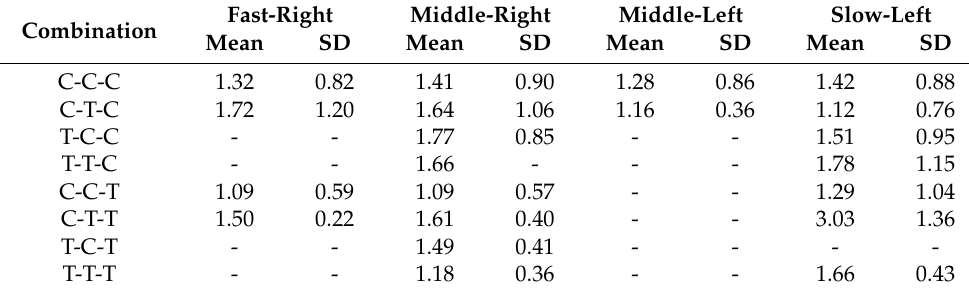
Table 3. The mean and standard deviation of T b of n5.